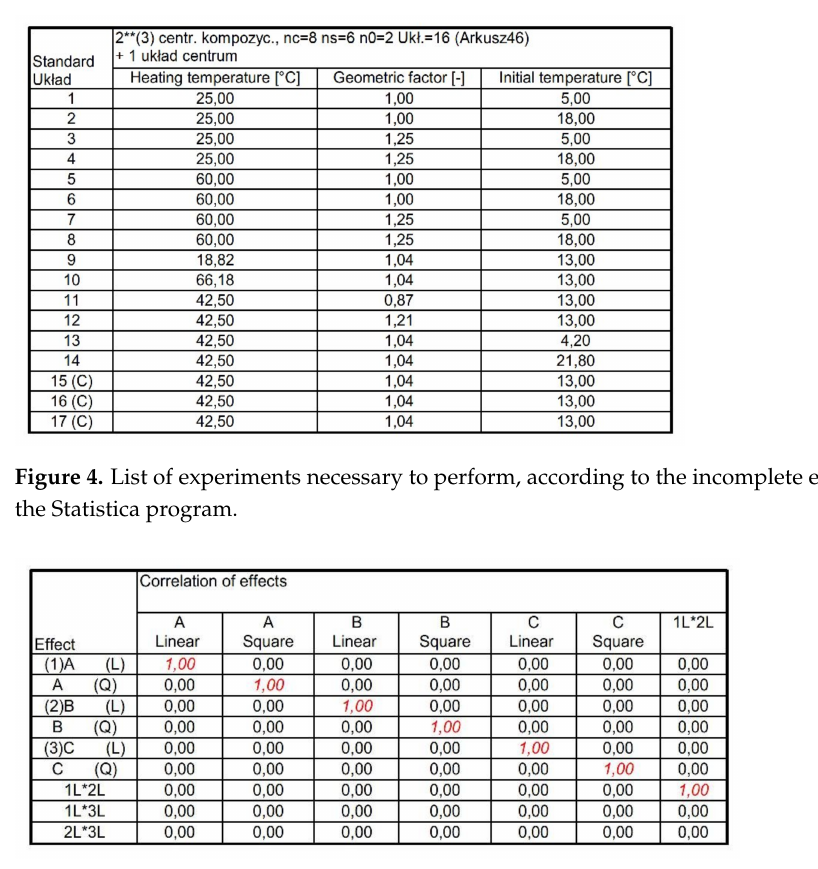
Figure 5. Summary of the effects of input variables and their correlations analyzed in the experiment plan in the Statistica